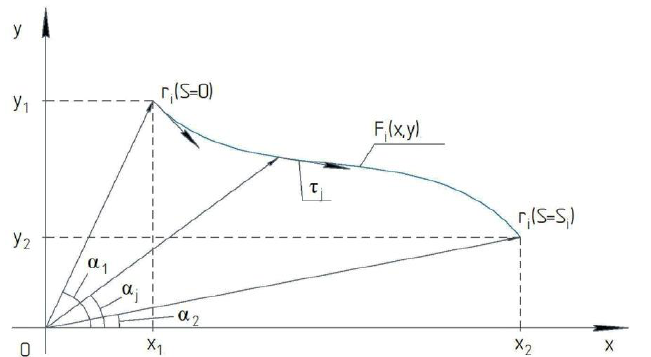
Figure 2. A fragment of the segment boundary described by the vector